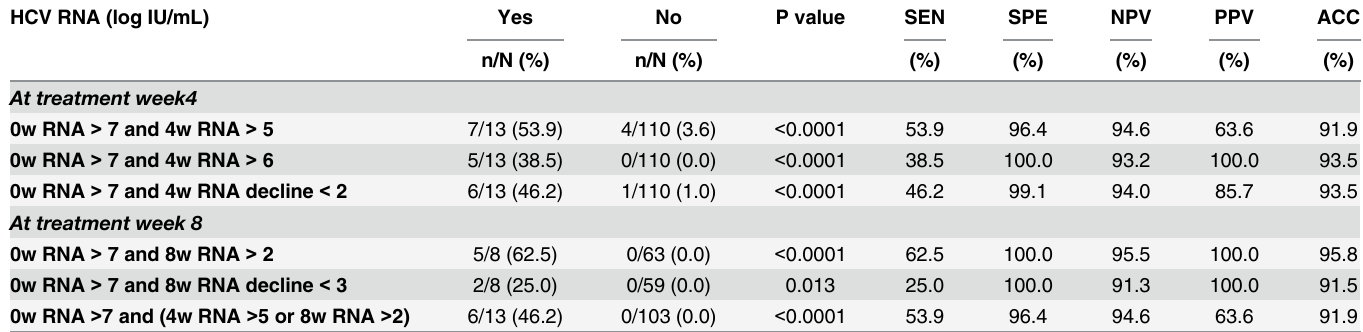
Table 7. Combined effects of viral kinetics in predicting week 12/24 futilities. Abbrviations: SEN, sensitivity; SPE, specificity; PPV, positive predictive value; NPV, negative predictive value; ACC, accuracy. HCV RNA (log